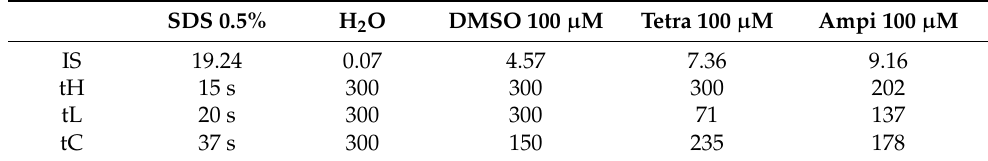
Figure 8. Representative stereomicroscopic images of CAMs (chorioallantoic membranes) treated with SDS—positive control, H 2 O; negative control, DMSO, ampicillin, and tetracycline. T 0 represents 0 min after application of the test compounds and T 5 represents 5 minutes after application of the compounds. Scale bar was 500 µM. Table 1 . Irritation score (IS) for SDS (sodium dodecyl sulfate), H 2 O, DMSO, ampicillin, and tetracycline (100 µM) and the occurrence time of hemorrhage (tH), lysis (tL), and coagulation (tC).